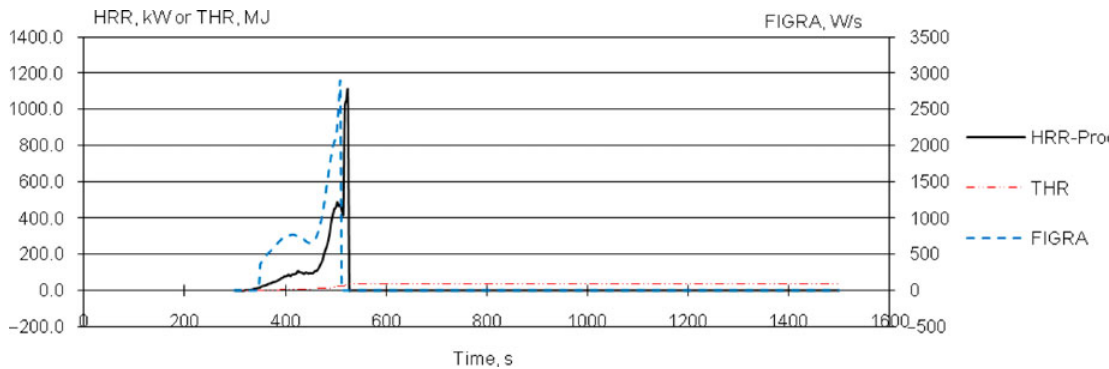
Fig. 7. HRR of non-impregnated 6 mm OSB